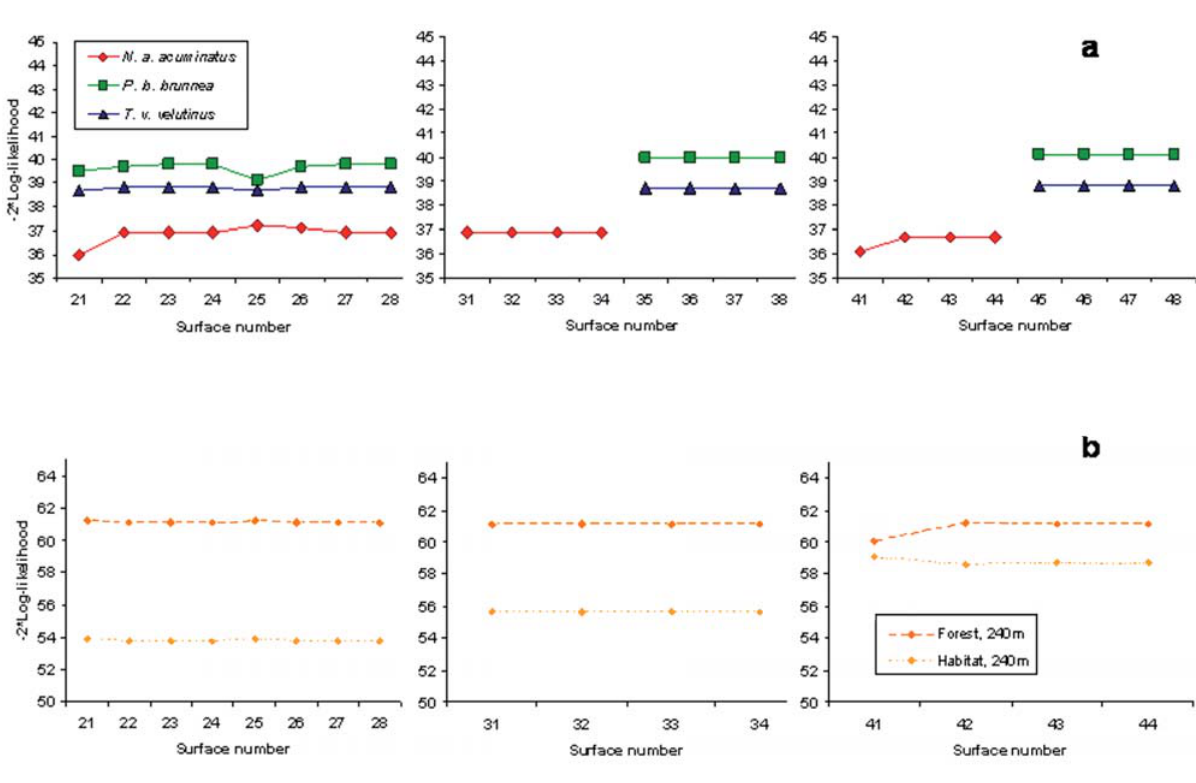
Figure 3. Log likelihood results for all cost surfaces in all broad groups. Forest/non-forest surface numbers start with 2, urban effect surface numbers start with 3, and agriculture surface numbers start with 4. The best-fitting cost surface in each group had the smallest y-value (-2*Log(likelihood)). Generalist species fits are depicted in (a), while all surfaces tested for the specialist U. despectus , i.e., forest as habitat at 240 m and pignut hickory as habitat at 240 m, are depicted in (b).